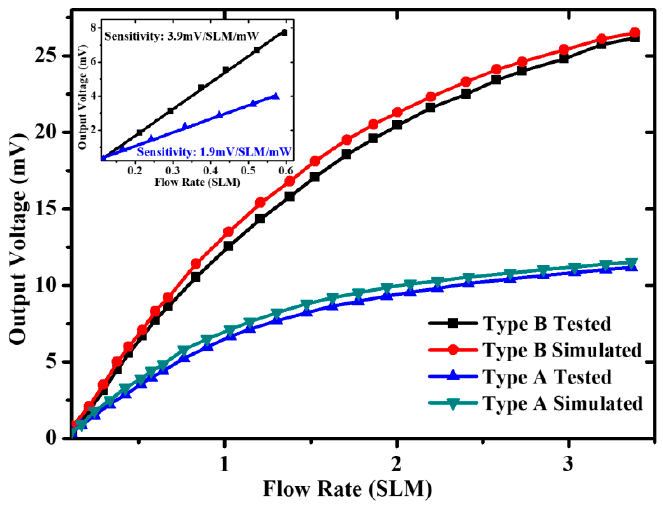
Figure 9. Measured output voltage of the fabricated sensor as a function of input flow rate.